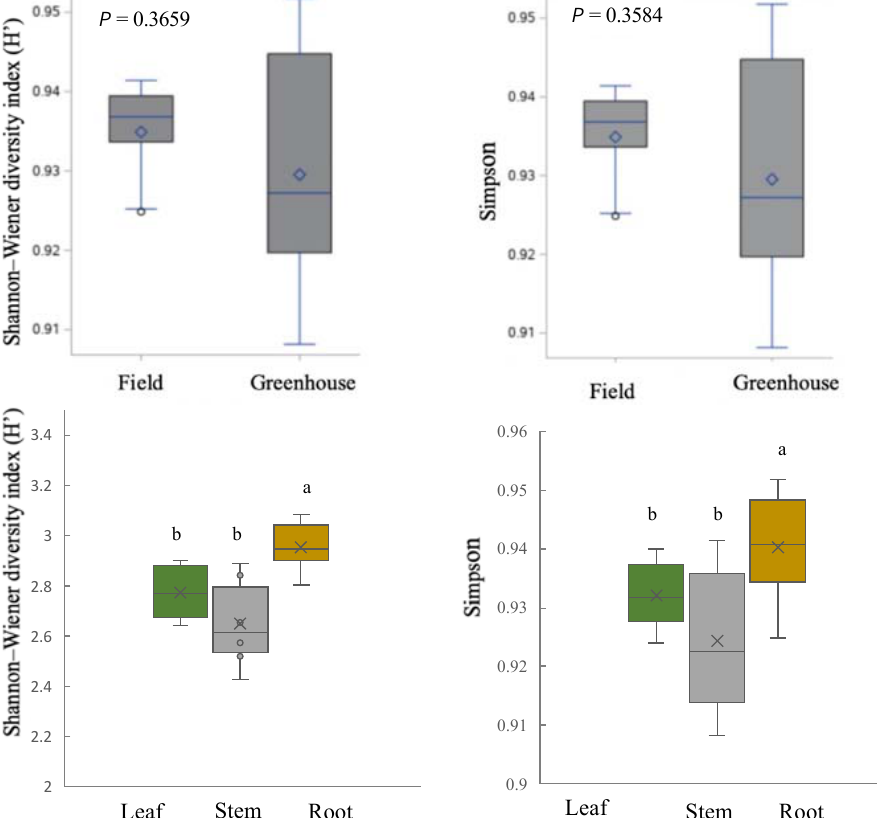
Figure 2. Fungal endophyte biodiversity analysis. The effect of the sampling growing conditions ( top ) and tissue types ( bottom ) on fungal endophyte biodiversity was measured using the Shannon– Wiener diversity (H’) and Simpson index. The endophytes were isolated from the leaf, stem, and root tissues of hairy vetch plants from two different growing conditions (field and greenhouse). Bars with different letters (a, b) indicate that the mean values are significantly different at a significance level of p < 0.05.